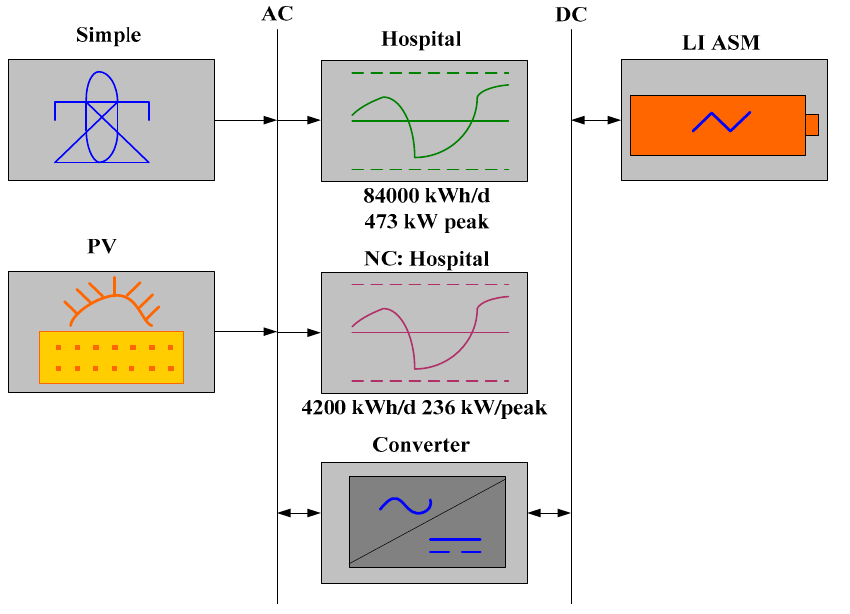
Figure 16. System 2: HOMER grid configuration.